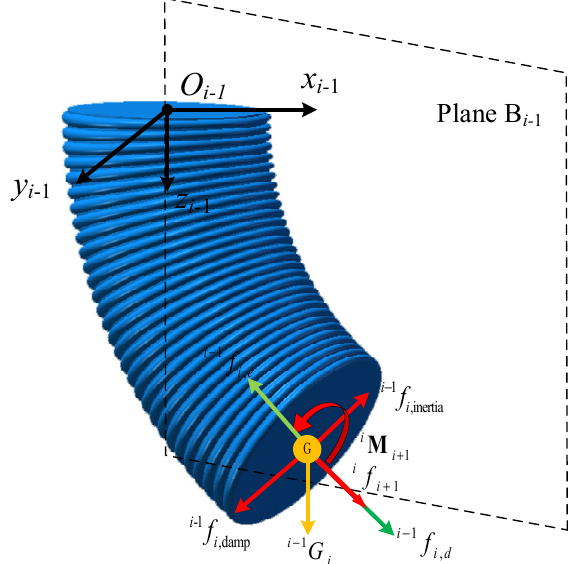
Figure 3. Force diagram of the soft manipulator in segment i .